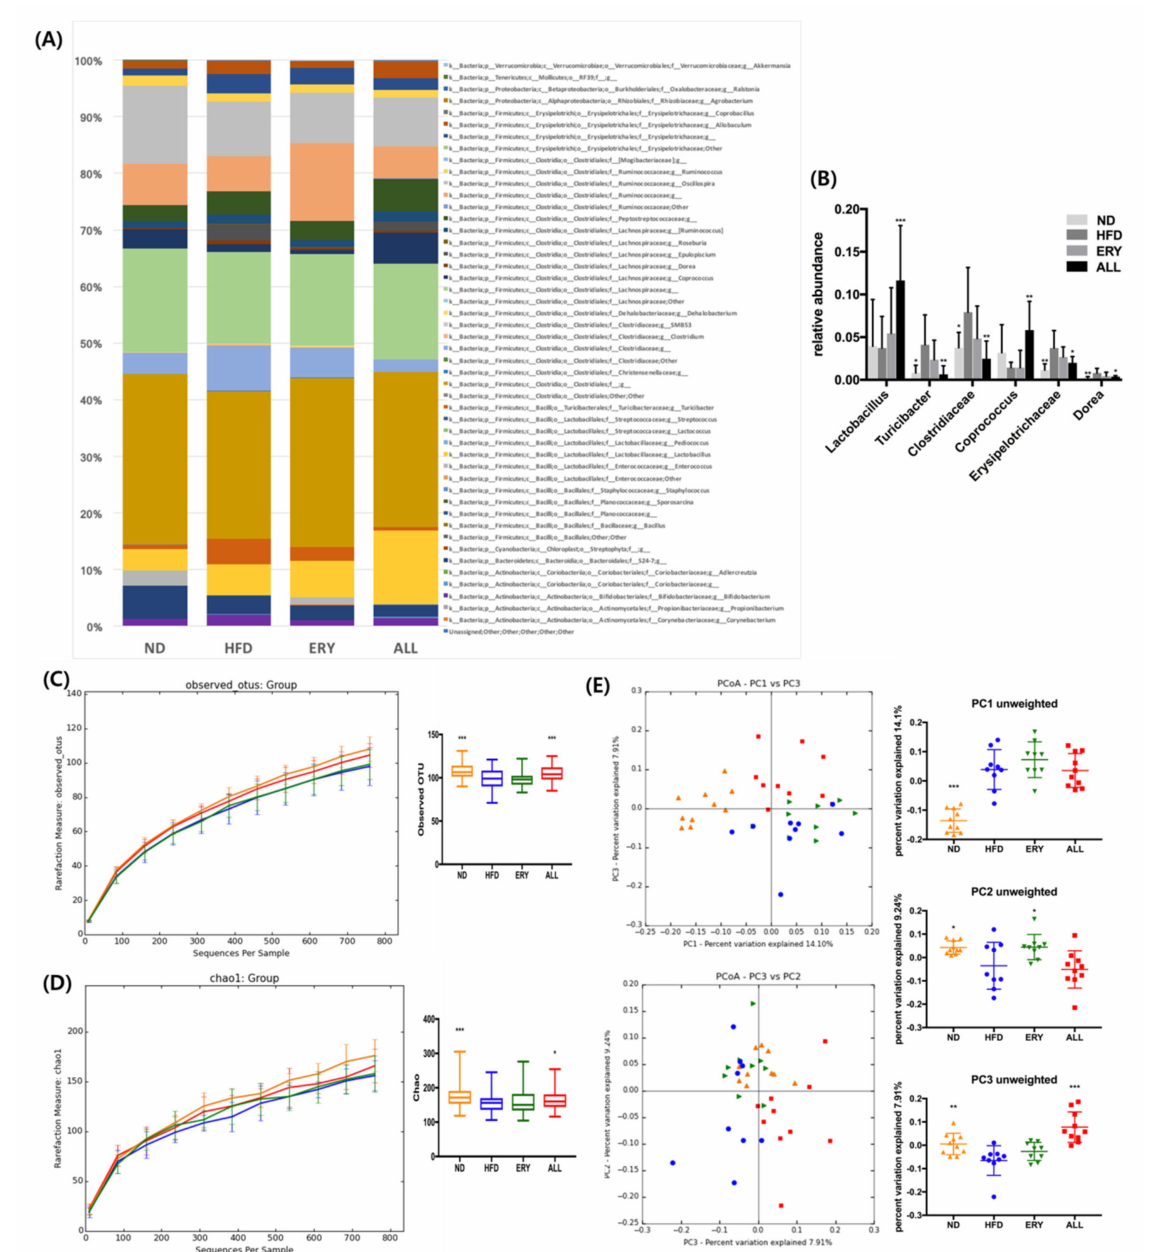
Figure 4. E ff ects of D-allulose on microbiota modulation. ( A ) Relative taxonomic abundance at the genus level. ( B ) Relative abundance of Lactobacillus , Coprococcus , Coprobacillus , Turicibacter , Clostridiaceae , Dorea , and Erysipelotrichaceae . ( C ) Observed operational taxonomic unit (OTU). ( D ) Chao 1. ( E ) Unweighted principal coordinates analysis and value of each principle coordinate dimension. Data are mean ± SE; ND, normal diet (AIN-76); HFD, high-fat diet (AIN-76, 20% fat, 1% cholesterol); ALL, (HFD + 5% D-allulose). Mean values are significantly di ff erent for HFD vs ALL, * p < 0.05, ** p < 0.01, *** p <